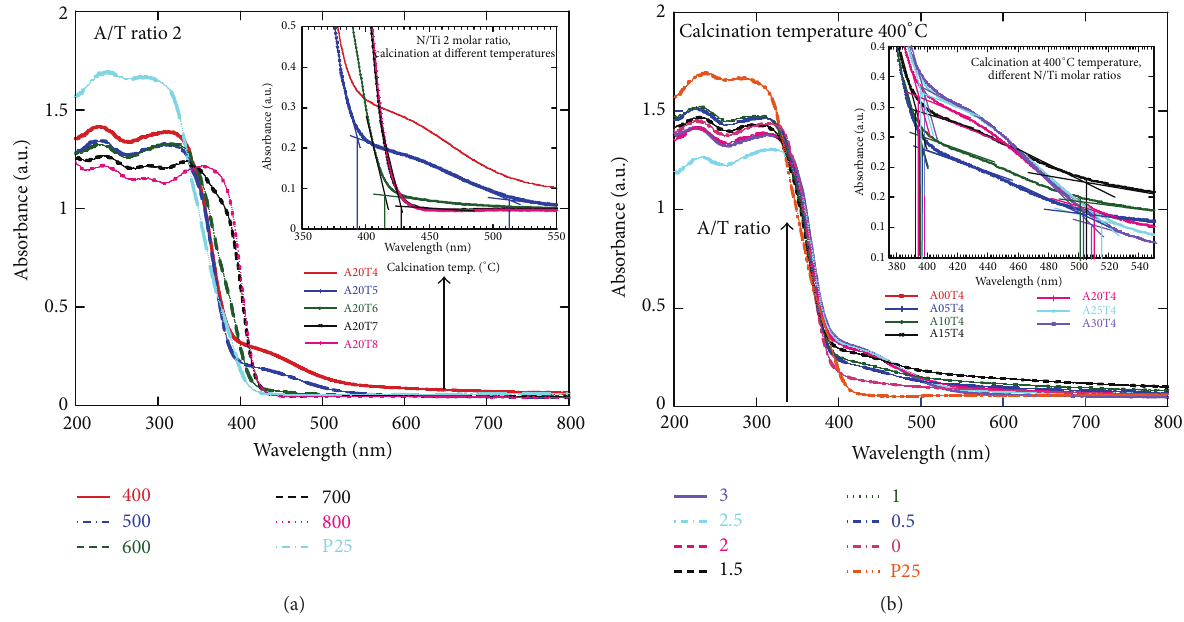
Figure 6: The typical UV-vis DR spectra of N-TiO 2 samples: (a) prepared with 2.0 ammonia/TTIP molar ratio and calcined at various temperatures; (b) prepared with various ammonia/TTIP molar ratios and calcined at 400 ∘